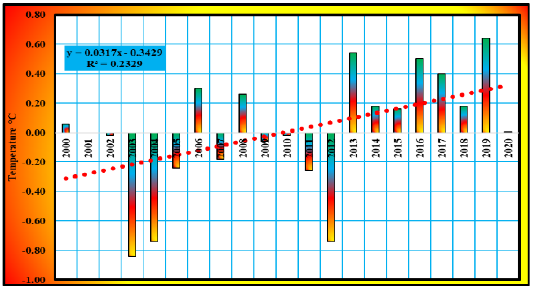
Figure 18: Represents Autumn Temperature Deviation in Ghotki district